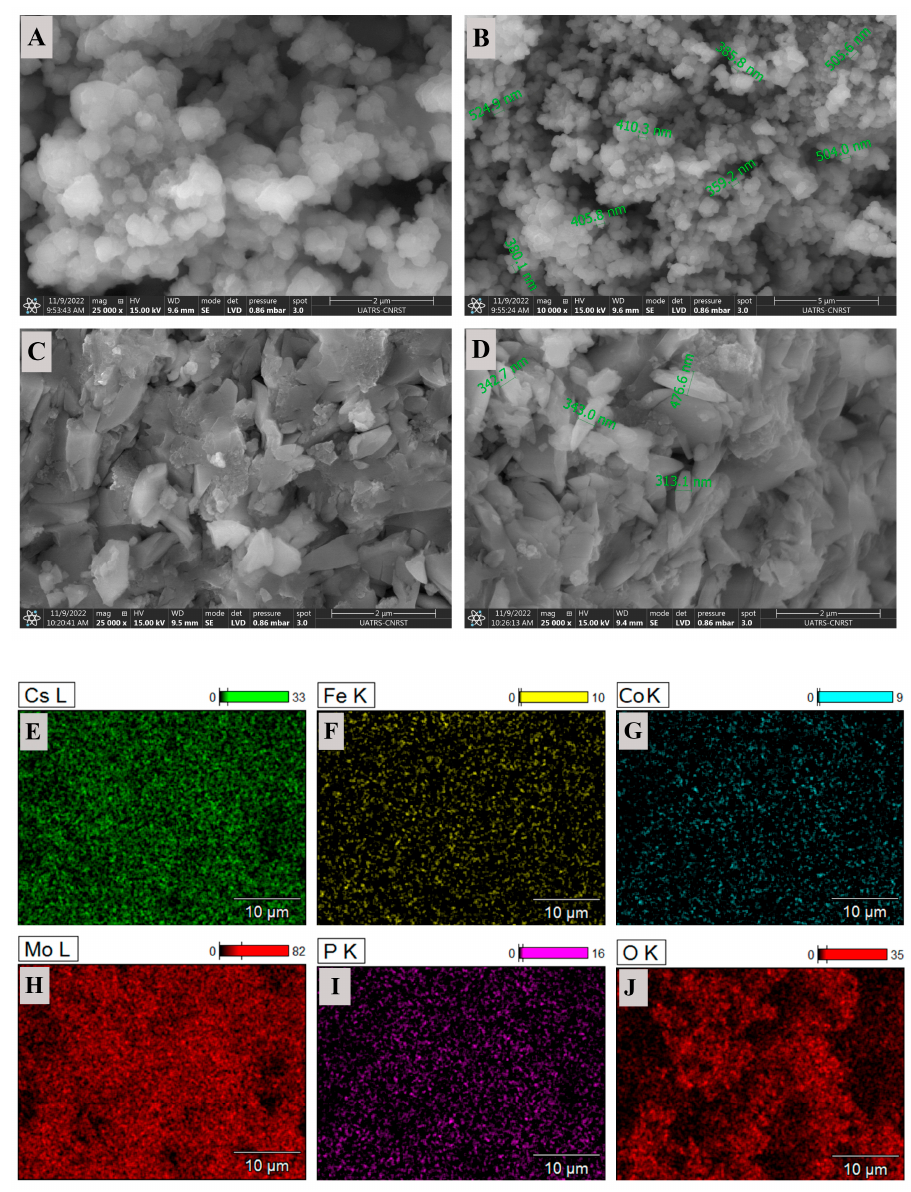
Figure 3. SEM images of Cs 5 PMo 11 FeO 39 ( A , B ), Cs 5 PMo 11 CoO 39 ( C , D ), and elemental mappings ( E – J ).